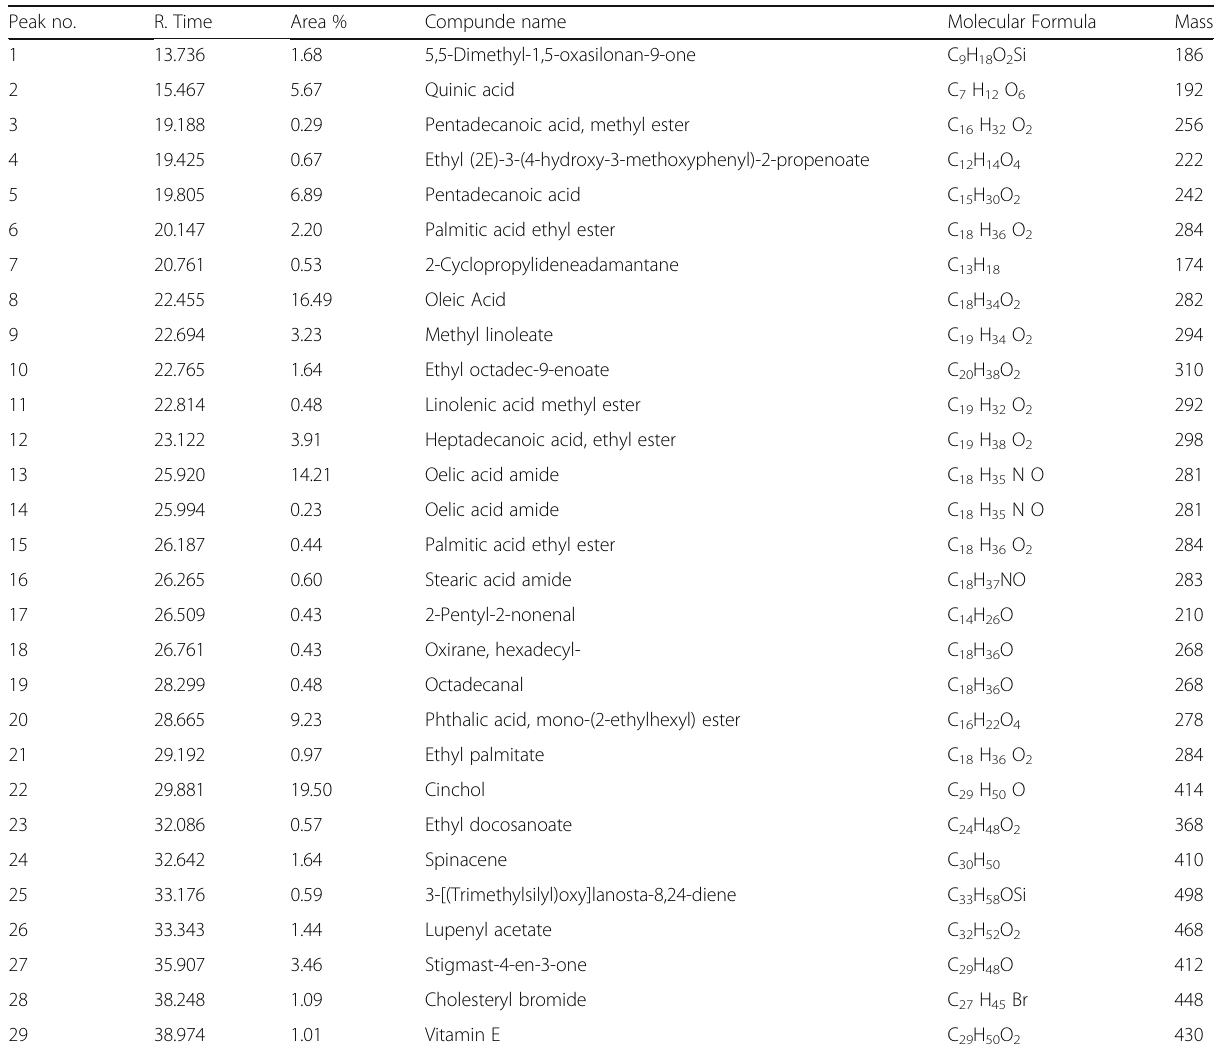
Table 4 GC-MS spectral analysis of hexane fraction of S. latifolius bark Peak no. R. Time Molecular Formula Mass